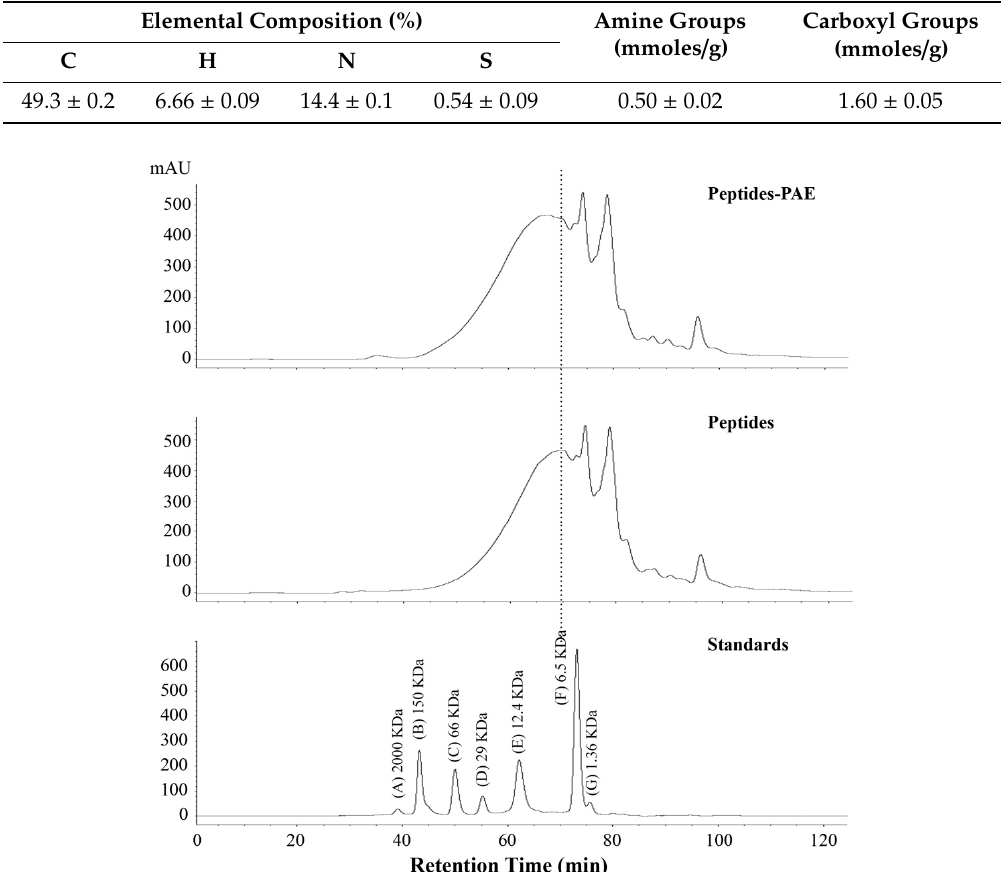
Figure 1. SEC-HPLC chromatograms of peptides and peptides-PAE binder formulation. The standards are (from left to right): Blue dextran (A; MW: 2000 KDa), alcohol dehydrogenase (B; 150 KDa), albumin (C; 66 KDa), carbonic anhydrase (D; 29 KDa), cytochrome C (E; 12.4 KDa), aprotinin (F; 6.5 KDa) and vitamin B-12 (G; 1.36 KDa). The molecular weight of the peptides ranged from as small